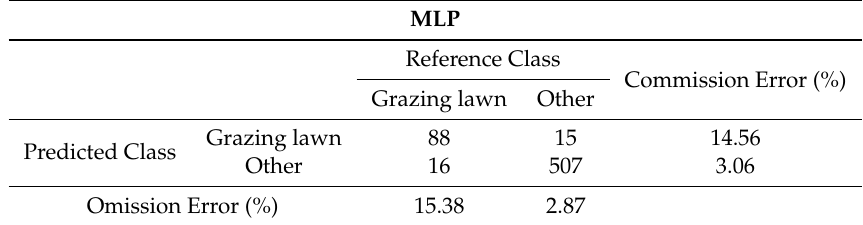
Table A9. Confusion matrix summarising results from Multilayer Peceptron (MLP) model classification of grazing lawn and other cover.